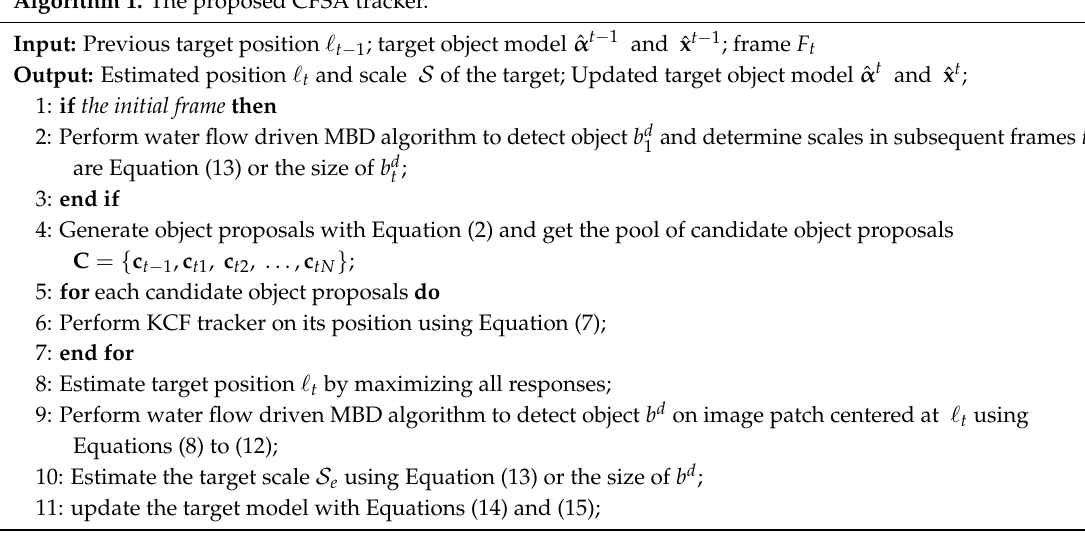
Algorithm 1. The proposed CFSA